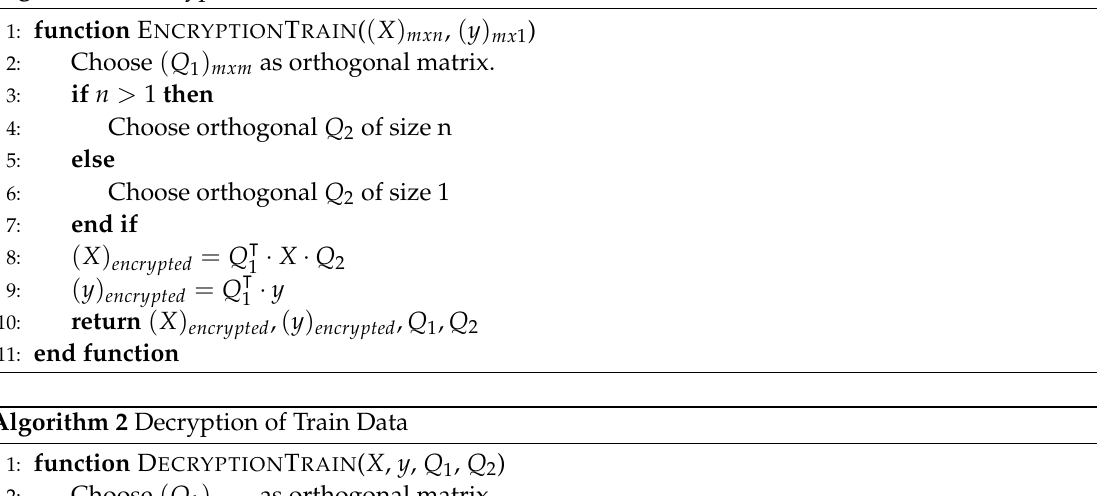
Algorithm 1 Encryption of Train Data